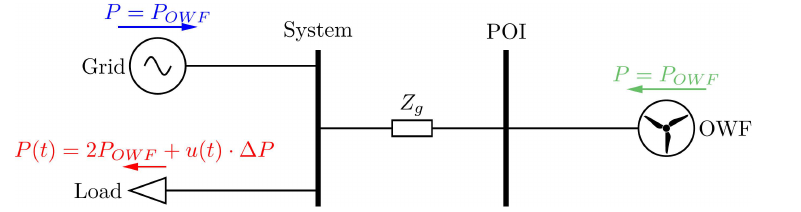
Figure 9. Generic offshore wind farm model.